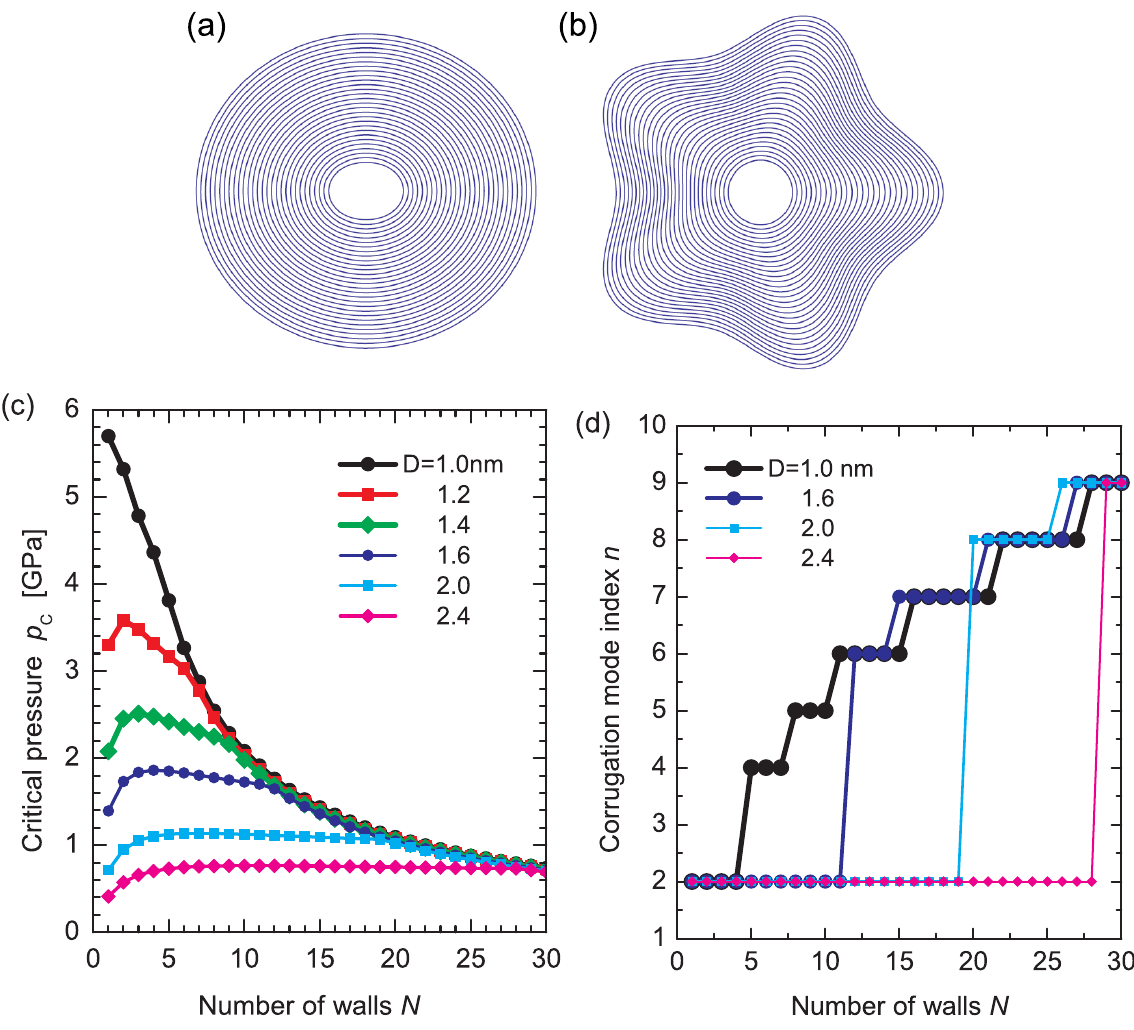
Figure 7. ( a ) Cross-sectional views of ( a ) elliptic ( n = 2) ; and ( b ) corrugated ( n = 5) deformation modes; The mode index n indicates the wave number of the deformation mode along the circumference; ( c ) Wall-number dependence of critical pressure p above p , the original circular cross section of MWNTs gets radially corrugated; ( d ) Stepwise c increase in the corrugation mode index n . Reprinted from References